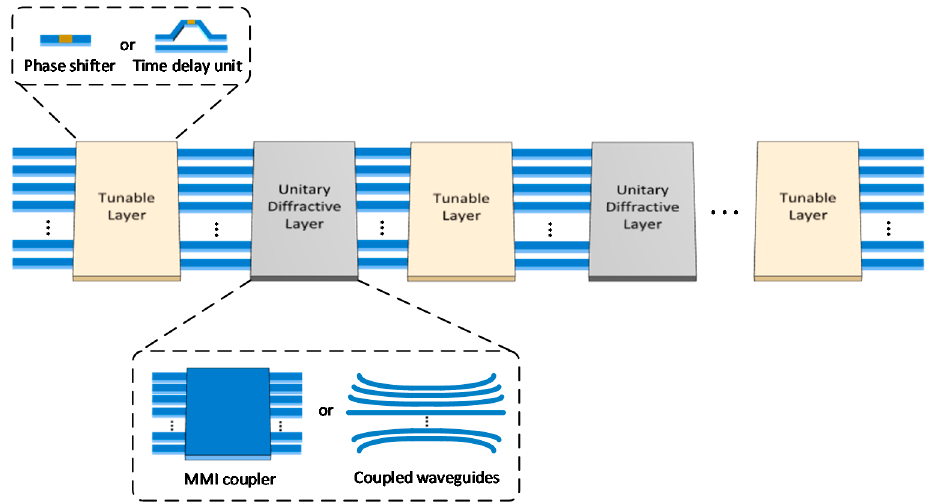
Figure 5. The structure of the integrated MPLC matrix core.